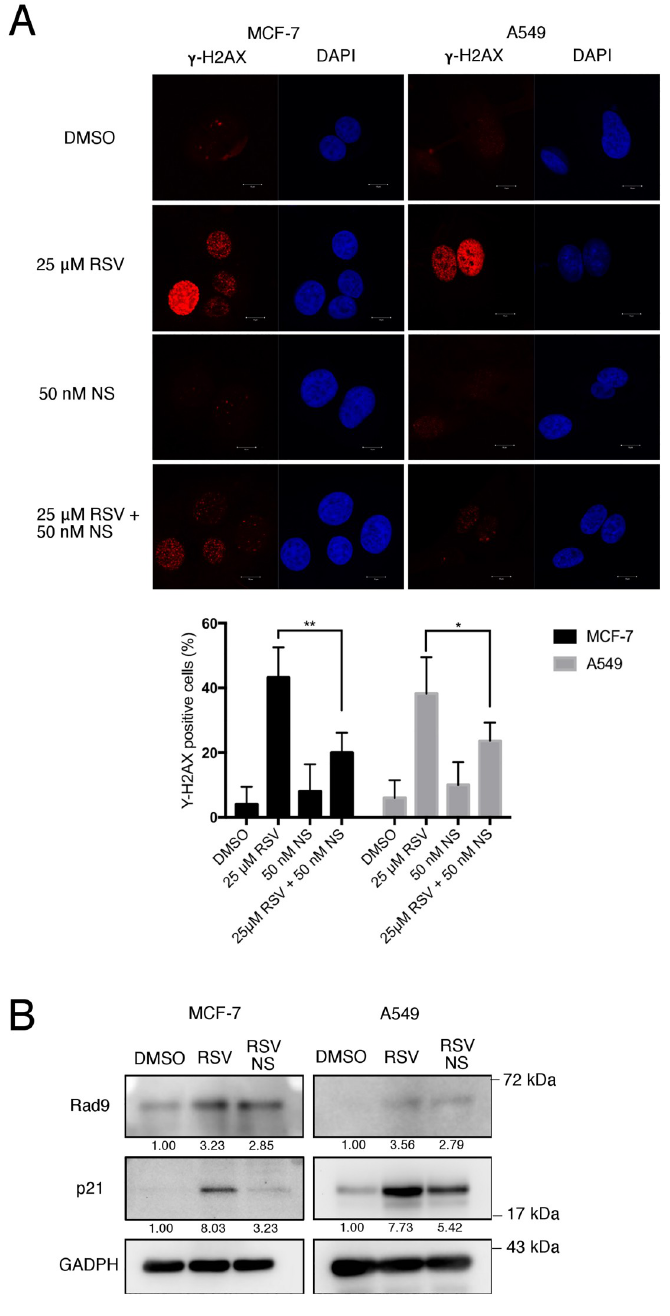
Fig 3. RSV induced Rad9 upregulation attenuated by nucleosides. (A) Immunofluorescence of gamma-H2AX in RSV treated MCF-7 and A549 cell lines. Cells were treated with RSV (25 μ M) or in combination with nucleosides (NS, 50 nM) for 24 h; stained with gamma-H2AX(Ser139) antibody (red) and counterstained with DAPI (blue). Scale bar, 10 μ m, representative of three independent experiments. (B) Western blotting was performed to determine the expression of Rad9 and p21 in MCF-7 and A549 cells treated with RSV (25 μ M) or in combination with NS (50 nM) for 24 h. Signals on the immunoblots were analyzed by ImageJ, normalized with that of GAPDH.